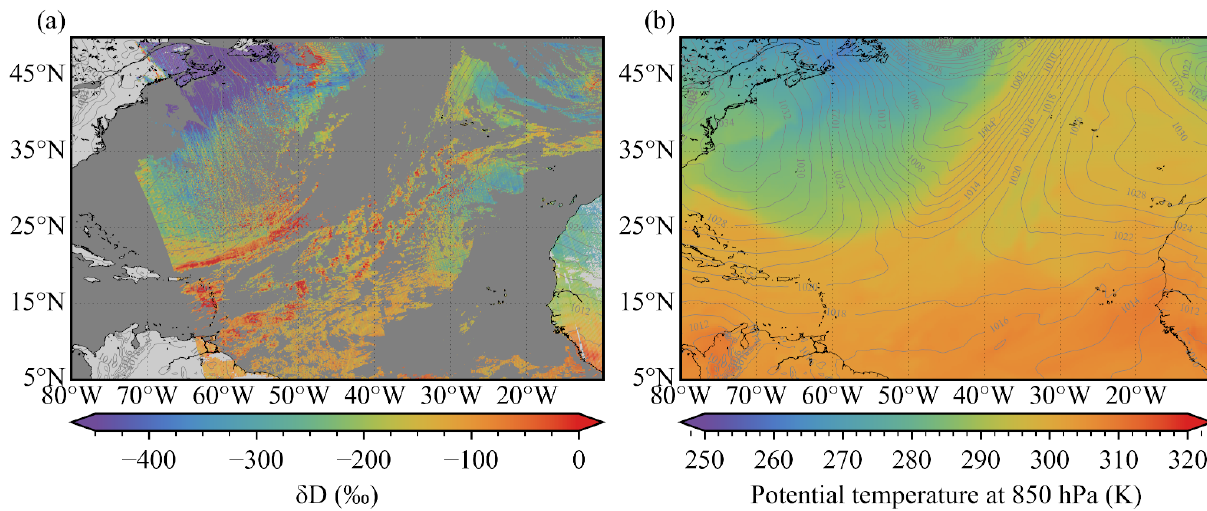
Figure 19. (a) TROPOMI single-overpass δ D and (b) ERA5 potential temperatures at 850hPa at 15:00UTC on 18 January 2020. The grey contours in all panels show ERA5 mean sea-level pressure at 15:00UTC with a contour line distance of 2hPa.